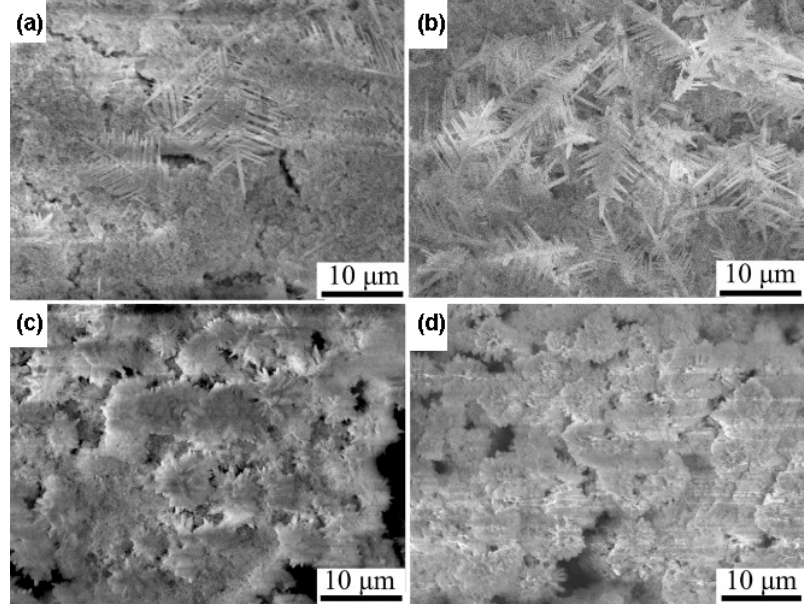
Figure 3. SEM images of SnO 2 leaf-like microstructure with different amounts of diammonium phosphate ( a ) 0.15 g, ( b ) 0.2 g, ( c ) 0.22 g, ( d ) 0.25 g. Reproduced from Ref. [62] with permission from Elsevier, 2018.